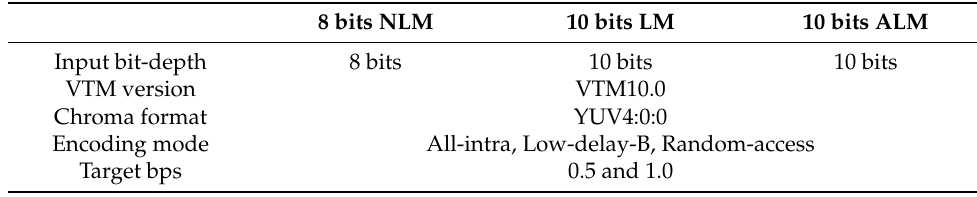
Table 3. Experimental environments for 2D audio encoding in the VVC.